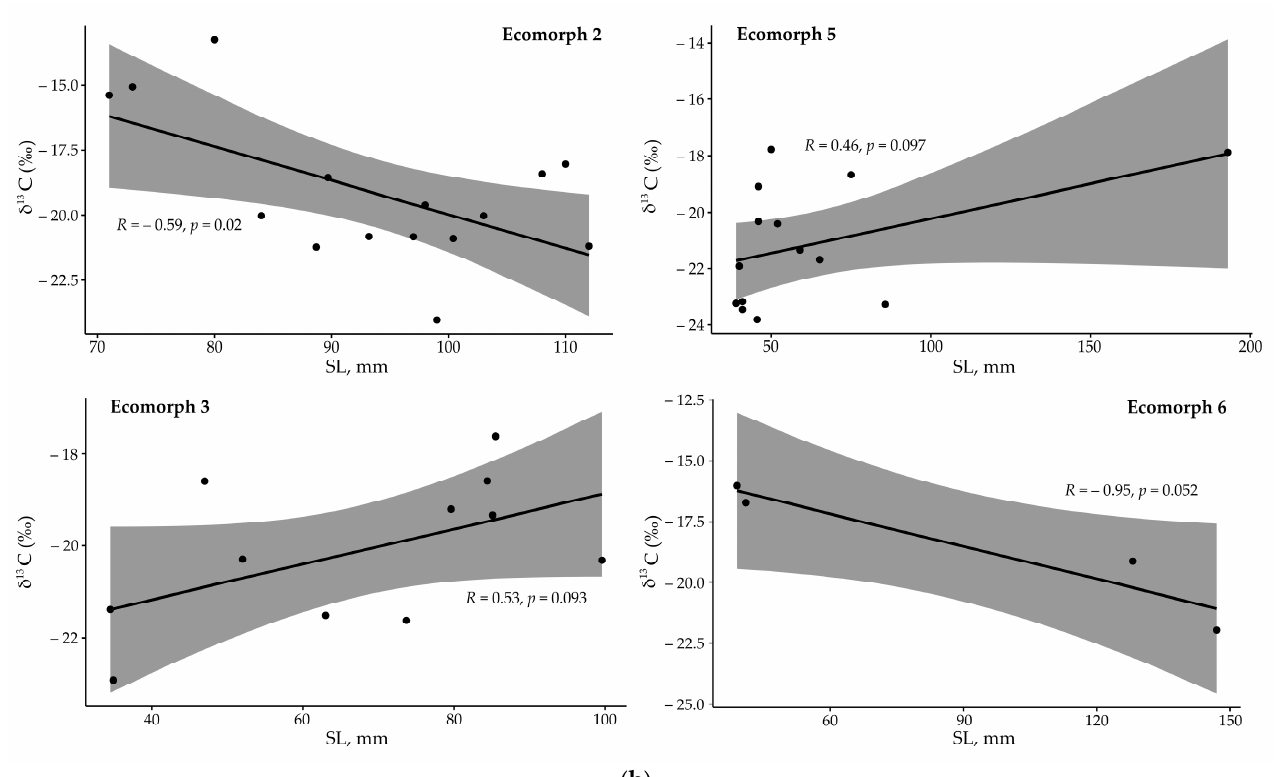
Figure 6. ( a ) Pearson correlation of the δ 15 N values with body length in six Garra ecomorphs from the Sore River. ( b ) Pearson correlation of the δ 13 C values with body length in six Garra ecomorphs from the Sore River.